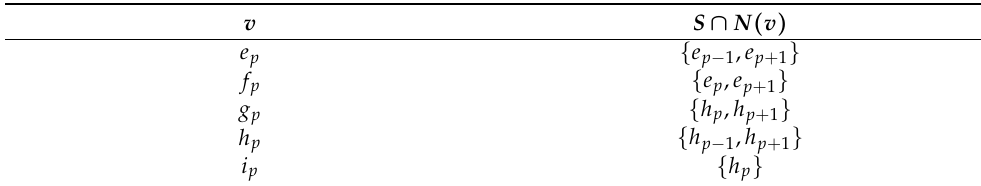
Table 6. Open locating-dominating vertices in R (cid:48) n .